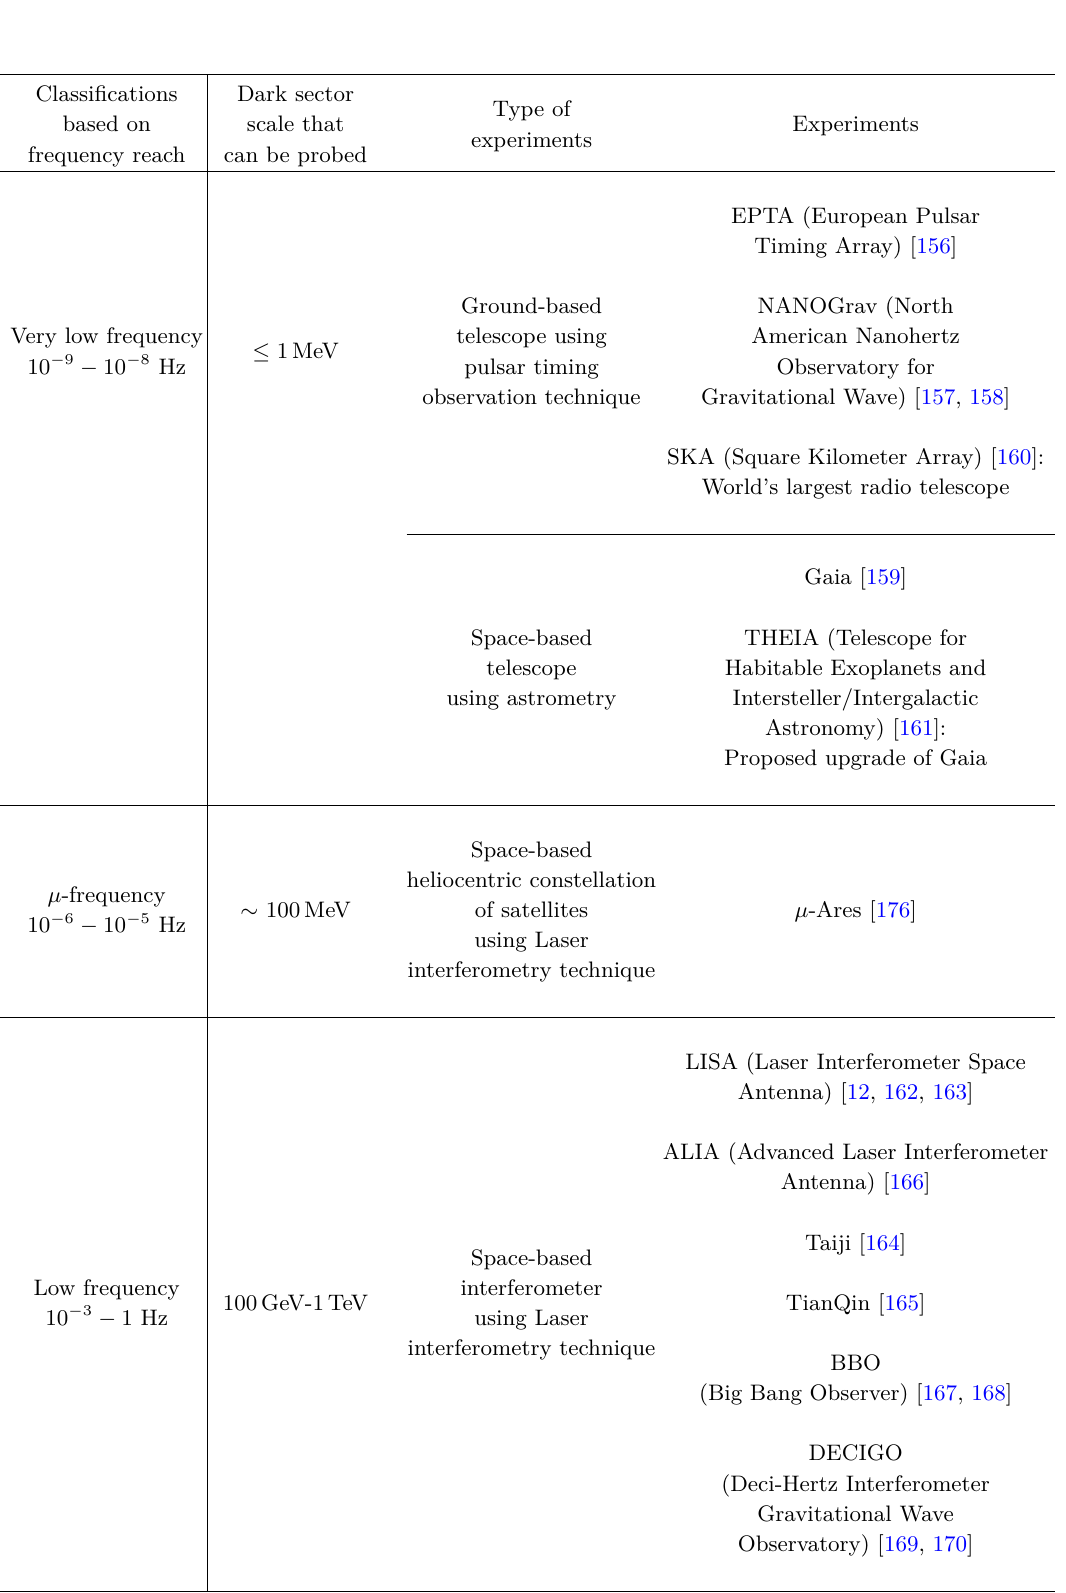
Table 1. Description of upcoming gravitational wave observatories, including the frequency range to which they would be sensitive, and the correspond symmetry-breaking scale